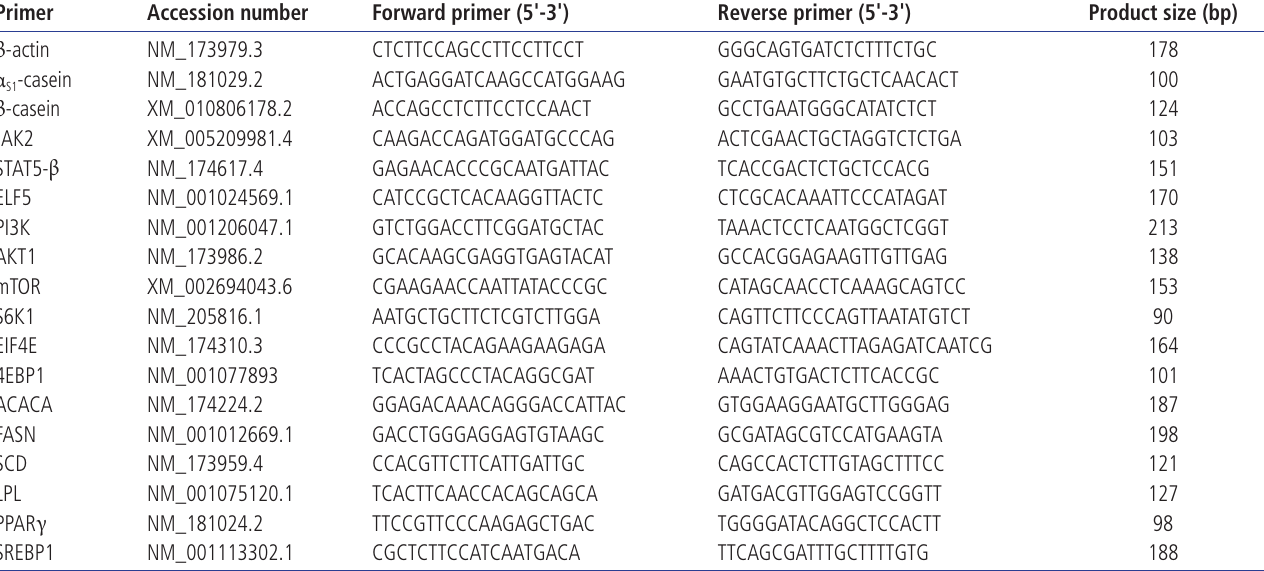
Table 1. Bos taurus primers used for quantitative polymerase chain